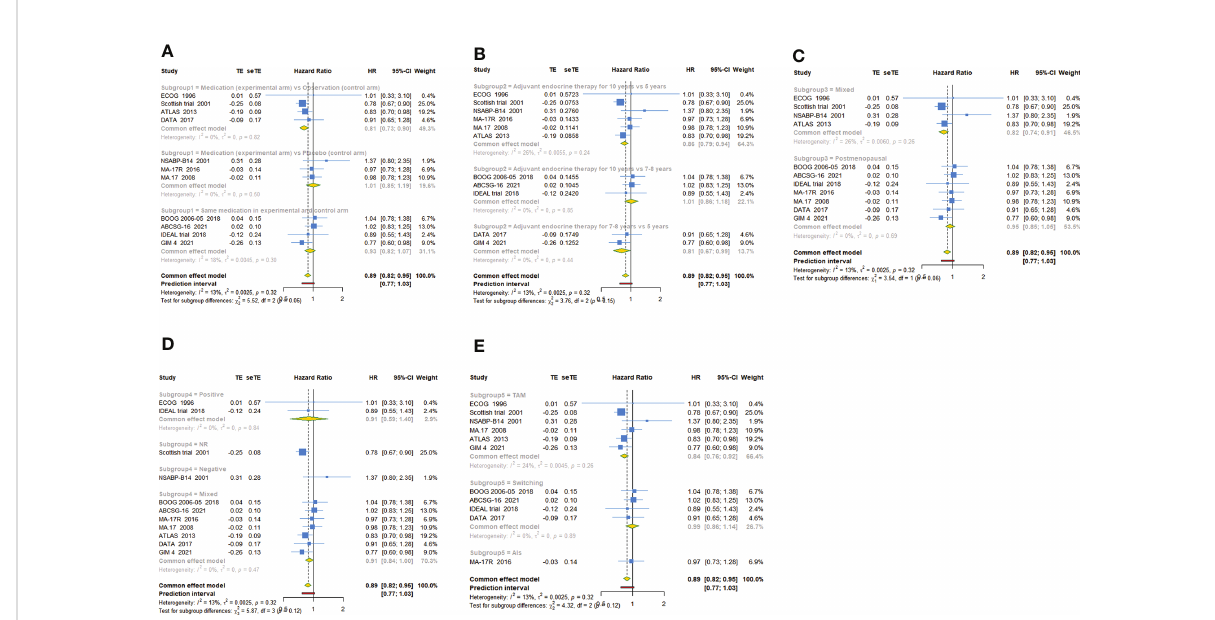
FIGURE 4 Forest plot of subgroup analysis of extended adjuvant endocrine therapy for overall survival (OS). (A) Subgrouped by the extended treatment method in experimental and control arm; (B) subgrouped by the duration of adjuvant endocrine therapy; (C) subgrouped by menopausal state of patients; (D) subgrouped by lymph node positive/negative; (E) subgrouped by the type of prior endocrine treatment.